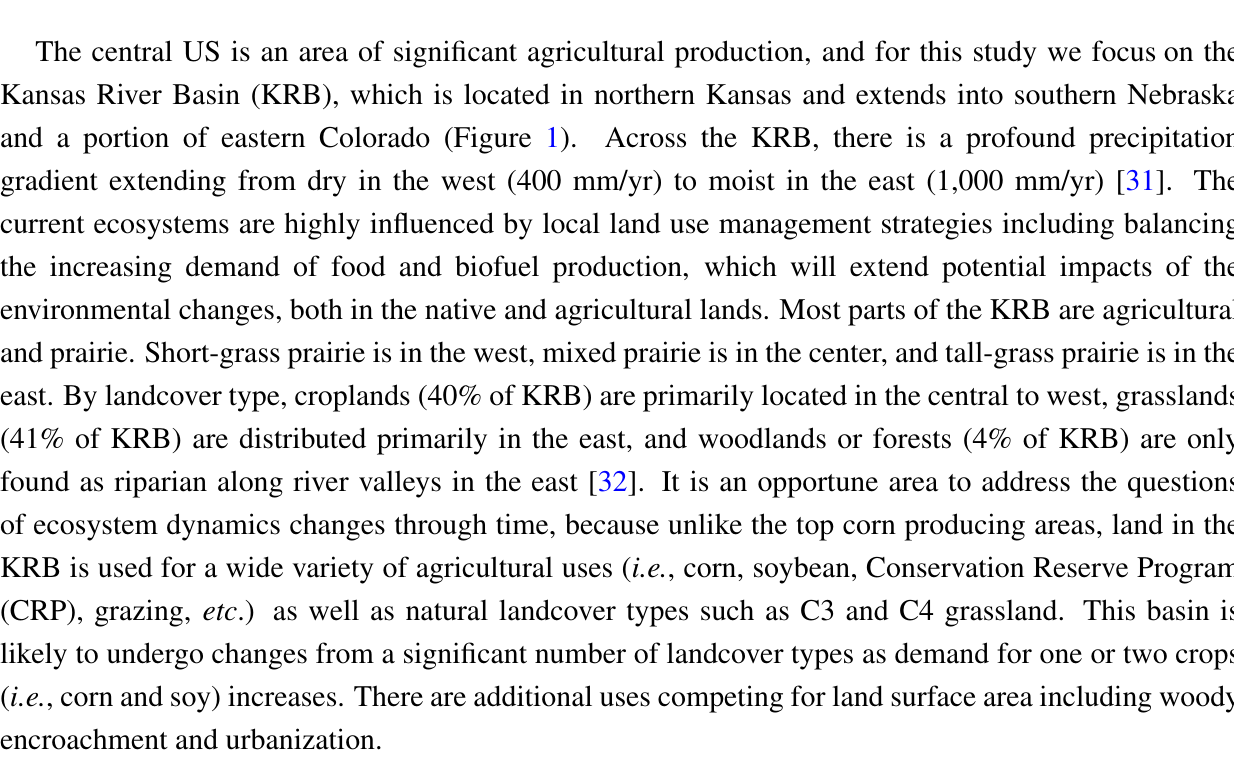
Figure 1. ( a ) Averaged annual precipitation (mm) in KRB in 1982–2006; ( b )